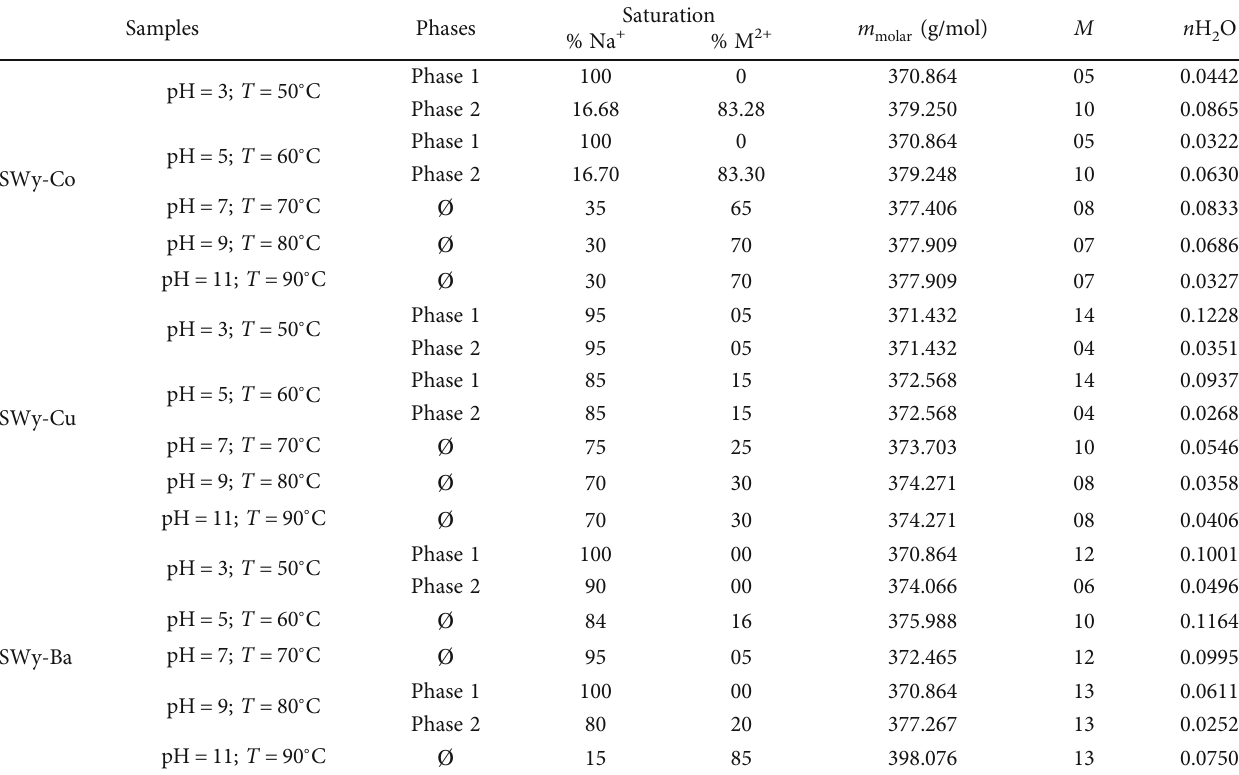
Table 10: Evolution of the nH